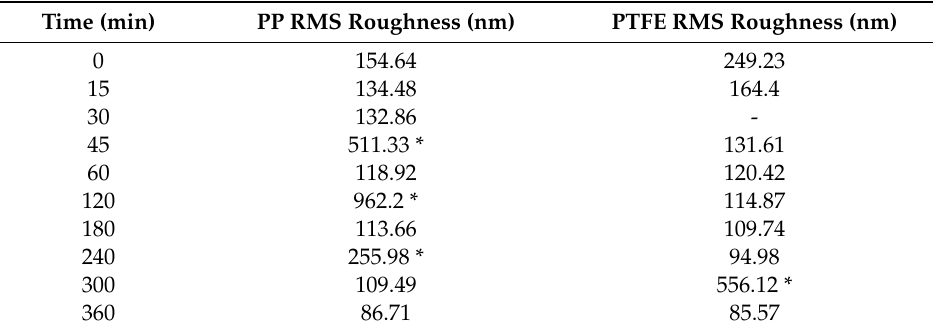
Table 2. LEP values obtained for PP and PTFE samples exposed to RCWW at different time intervals.